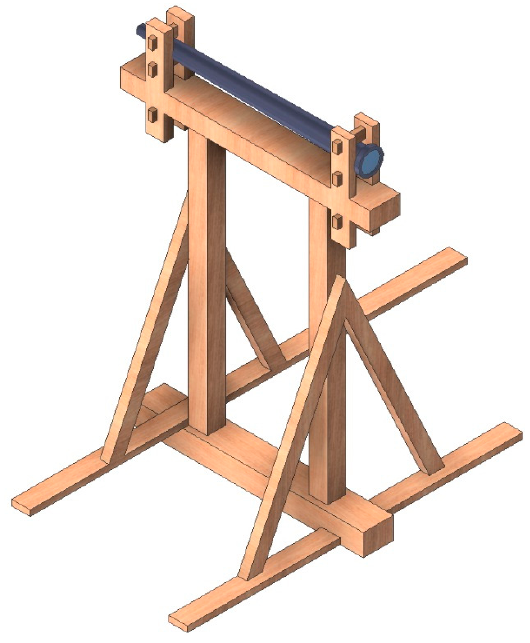
Figure 15. Telescope frame.